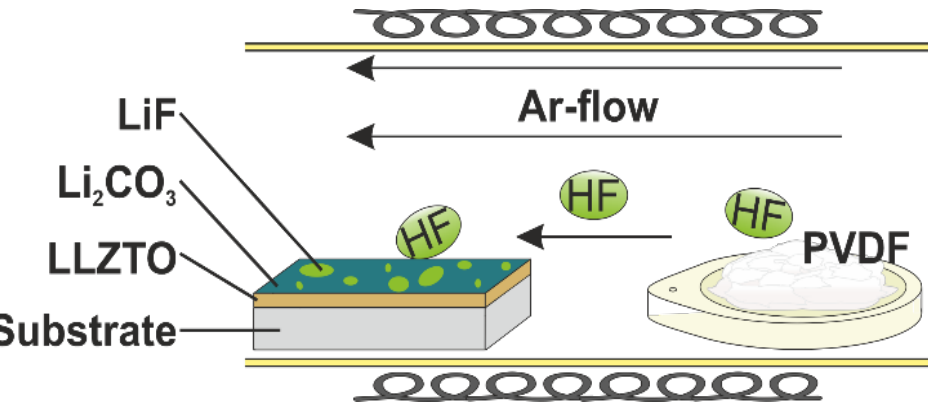
Figure 1. Schematic synthesis setup for the gas-phase fluorination.